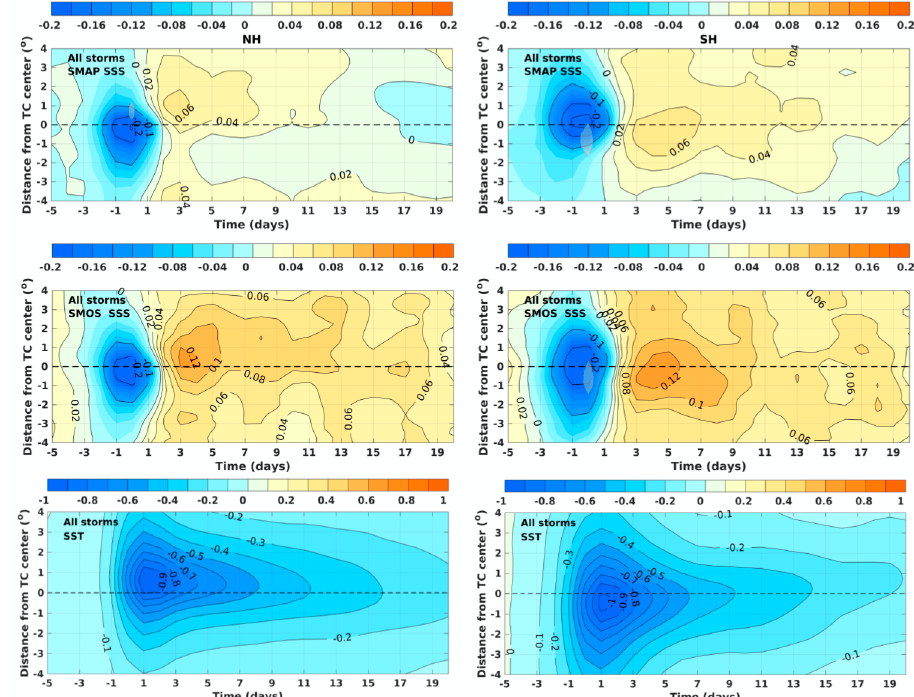
Figure 7. Along-track averaged composites of SSS anomaly relative to the reference SSS calculated with SMAP swath daily data (psu; upper panels) and SMOS swath daily data (psu; middle panels) and SST anomaly relative to the reference SST (°C; lower panels) for Northern (left panels) and Southern (right panels) Hemisphere. Both the SMAP and SMOS SSS associated with high surface wind are removed. The gray shading indicates the region where more than 30% of the SSS pixels are removed. The y-axis is the cross-track direction ±4° to the right and left of the track. Composite SSS (SST) anomaly relative to the reference SSS (SST) along-track ±4° to the center is averaged from days − 5 to 20.